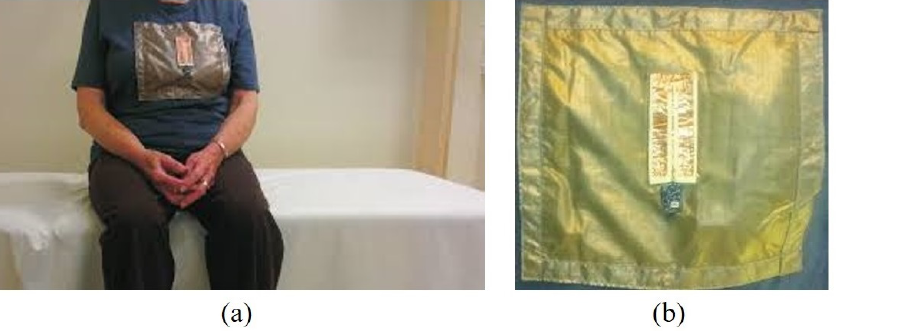
Figure 1. Wearable sensor settings during data acquisition: ( a ) positioning of the W 2 ISP sensor on the subject’s body, ( b ) the W 2 ISP sensor attached to the subject’s clothing with isolating silver fabric